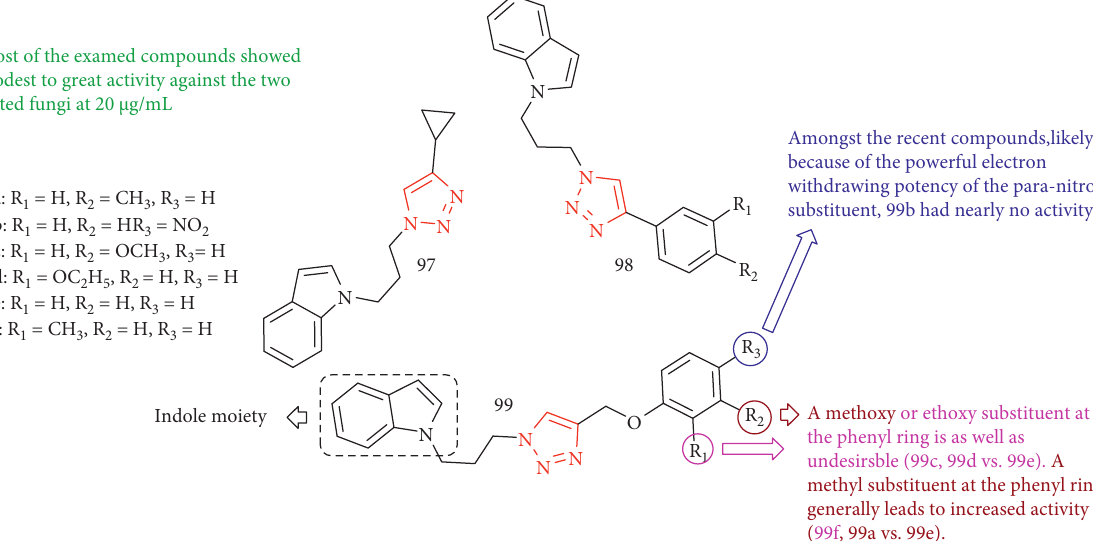
Figure 44: Chemical structure of novel 1,4-disubstituted 1,2,3-triazoles containing indole framework.